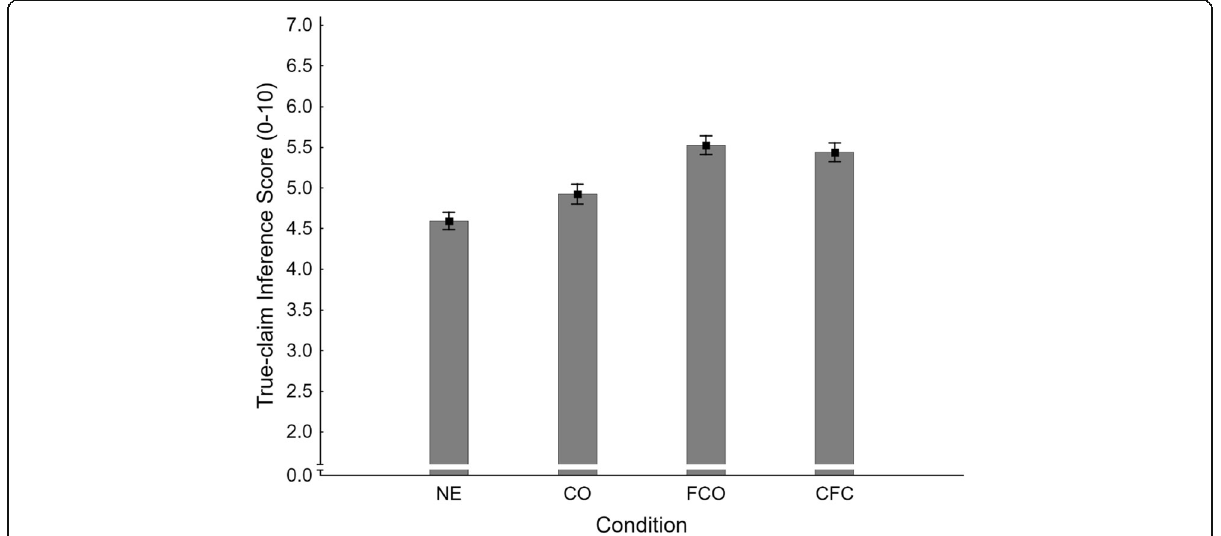
Fig. 5 Mean true-claim inference scores across conditions NE (no-exposure), CO (claim-only), FCO (fact-check-only), and CFC (claim-plus-fact- check) in Experiment 1. Error bars show standard errors of the